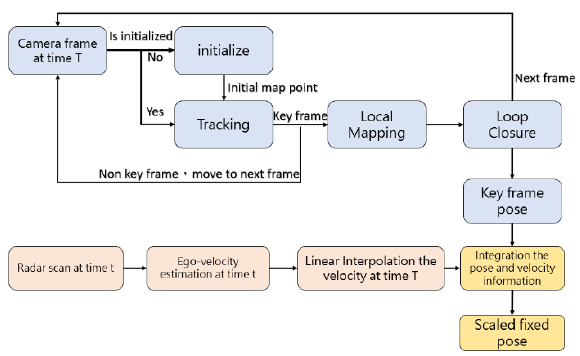
Figure 4. The Visual Radar odometry integration